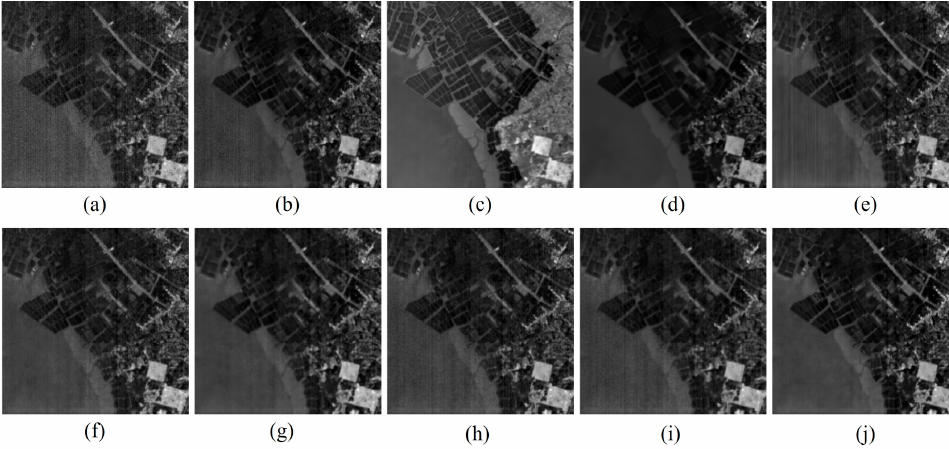
Figure 13. The denoised results on band 2 of the GF-5 data. ( a ) Original; ( b ) LRMR; ( c ) NAILRMA; ( d ) NGmeet; ( e ) L1HyMixDe; ( f ) E3DTV; ( g ) LRTDTV; ( h ) HSI-DeNet; ( i ) HSID-CNN; ( j ) ours.